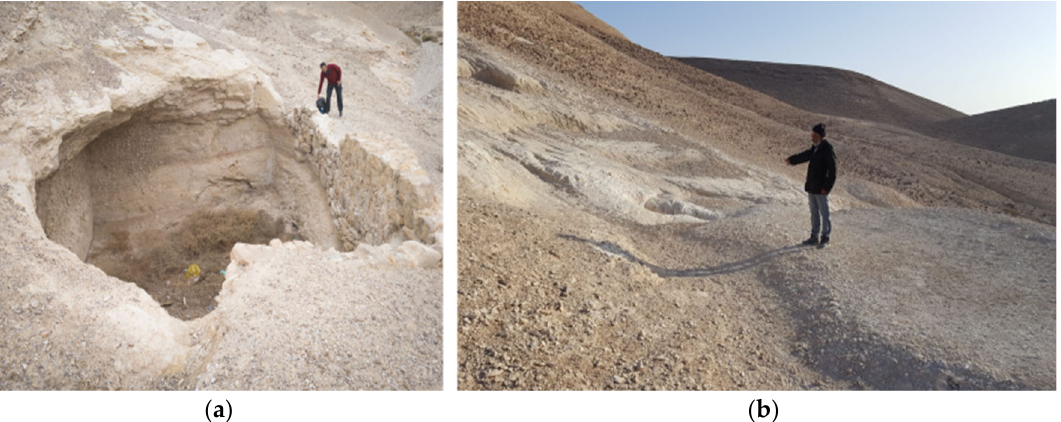
Figure 5. ( a , b ) Examples of few of the typical water cisterns found in the area of the “Negev” desert, which until only a few decades ago served as the principal water source for the Bedouins, and nowadays are neglected and unused. The photograph was taken during the artists research tour of the area in 2019, when they were accompanied by one of the Bedouin residents. Photographed by Dan Farberoff. Image courtesy of the artist.